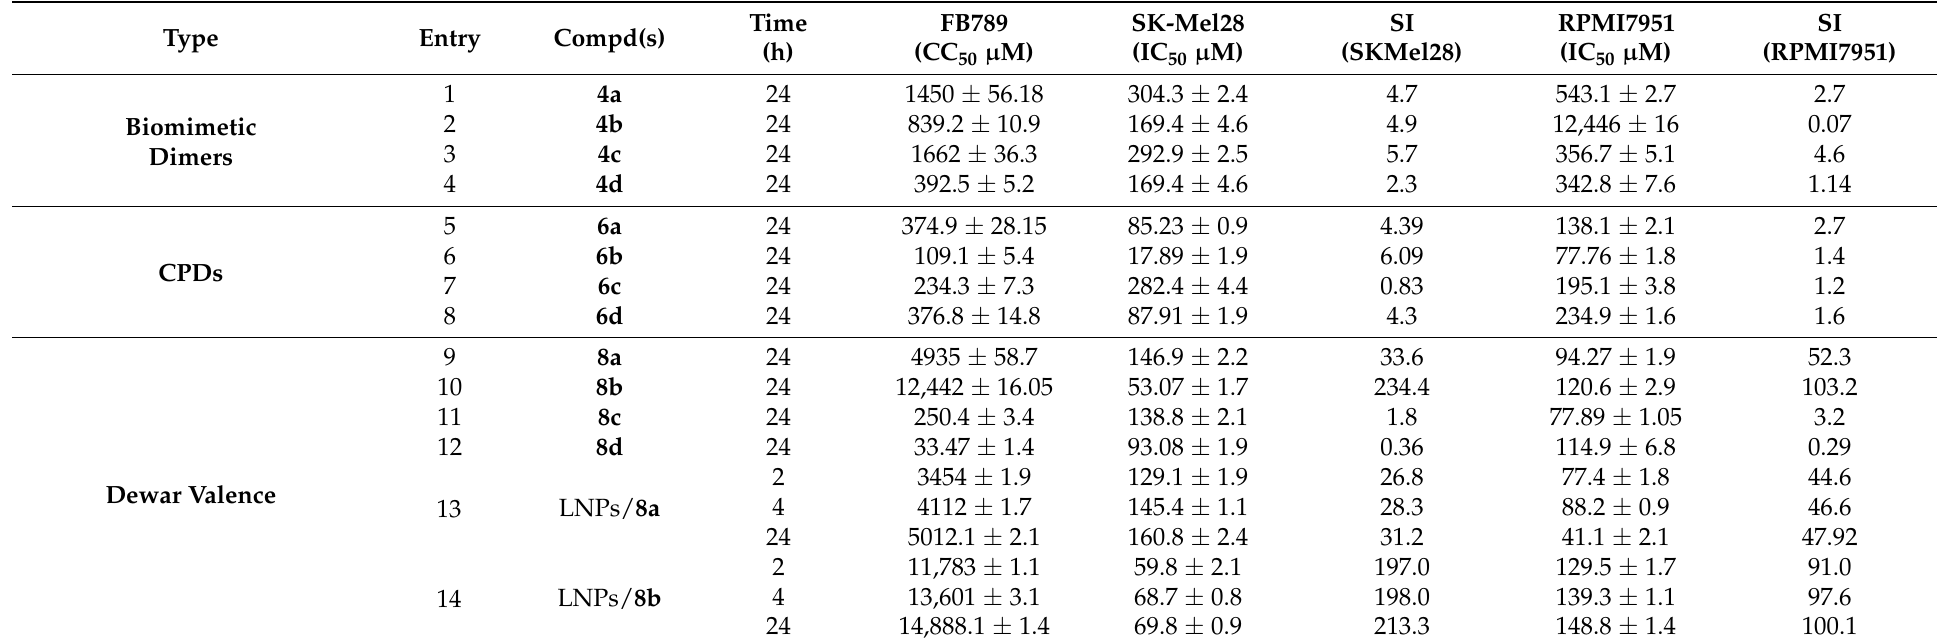
Table 5. Antimelanoma activity of biomimetic thymine dimers 4a - d and photo-adducts 6a - d and 8a - d